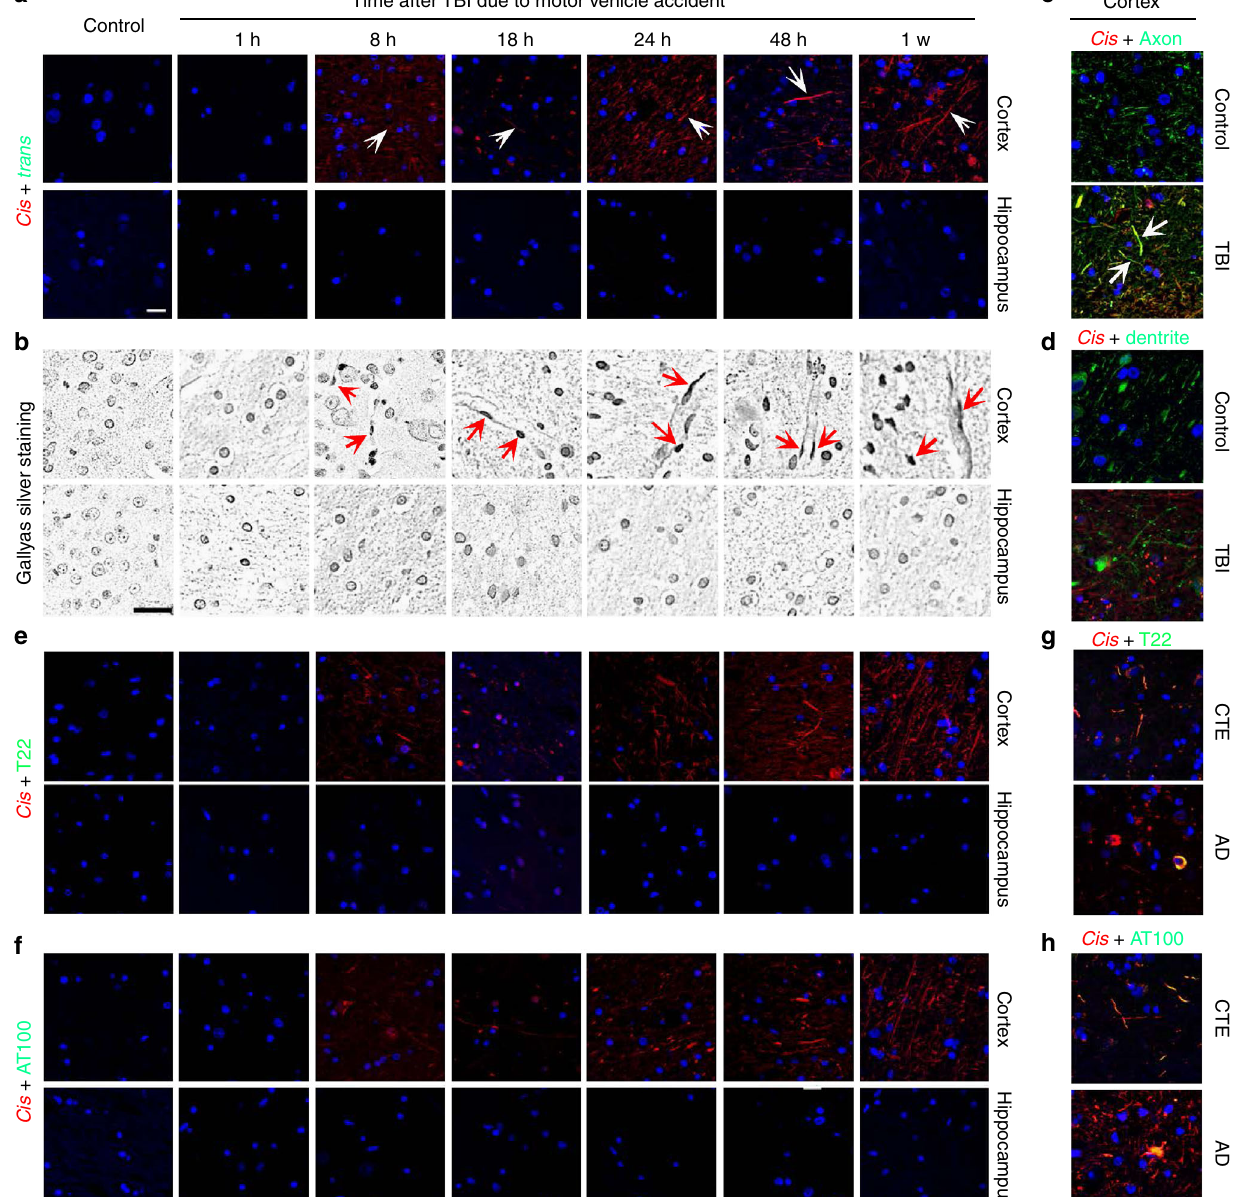
Fig. 1 Severe TBI in humans due to motor vehicle accidents, assaults or falls induces prominent axonal injury and axonal cis P-tau induction in the cortex. a , b Severe TBI in humans induces early cis P-tau induction and axonal injury in the cortex. Whereas neither cis nor trans P-tau nor axonal injury was detected in normal brains or 1 h after TBI due to motor vehicle accident, robust cis P-tau and axonal injury, but not trans P-tau were detected in the cortex, but not in the hippocampus, as early as 8 h after motor vehicle accident, as detected by double IF, followed by isotype-speci fi c secondary antibodies a or Gallyas silver staining b . Microscope images correspond to the cortex and hippocampus of control and TBI patients. TBI cases due to falls and assaults are shown in Supplementary Fig. 1. The number of TBI patients is 14. White arrows point to cis P-tau localization to axons; Red arrows point to axonal bulb. White scale bars, 20 µ m and black scale bars, 40 µ m. c , d cis P-tau (red) is diffusely co-localized (white arrows) with the axon marker tau (green) c , but not the dendrite marker MAP2 (green) d in human TBI cortex, with little cis in control, as detected by double IF, followed by confocal microscopy. e − h Cis P-tau is robustly induced after TBI in the absence of tau oligomers or tangles. Cortical sections of severe human TBI due to motor vehicle accidents were doubly immunostained with cis mAb (red) and T22 (tau oligomers) e , g or AT100 (tau tangles) f , h , followed by confocal microscopy. Normal controls as well as CTE and AD brains were used as negative and positive controls, respectively. Of note, cis mAb partially co-localized with T22 or AT100 in CTE or AD brains, but not in acute TBI